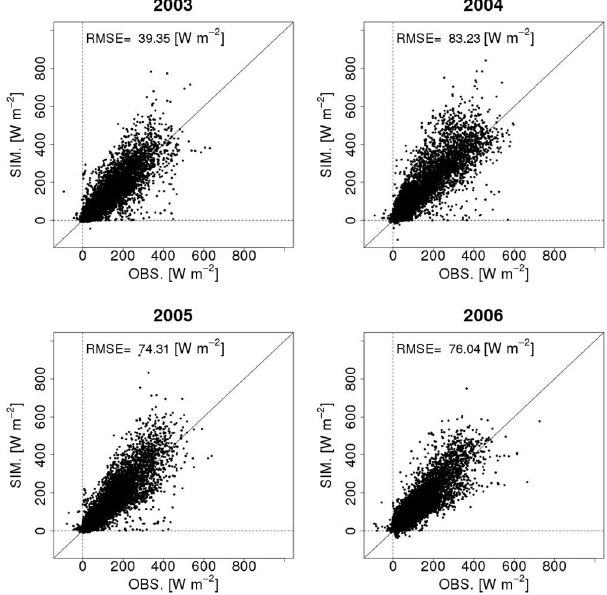
Figure 8. Comparison of half-hourly LHF between simulations and